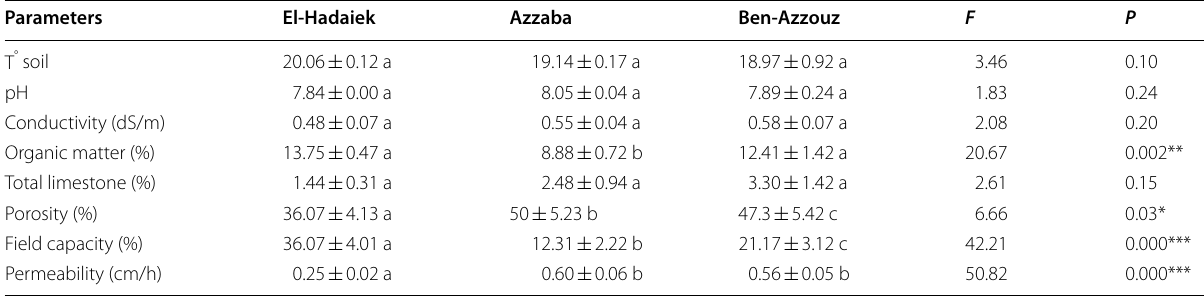
SD, n 3), analysis of variance (ANOVA) and Tukey’s test ± =